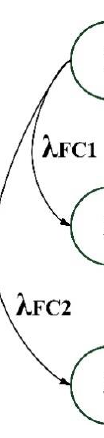
Figure 5. State-space diagram of the machine